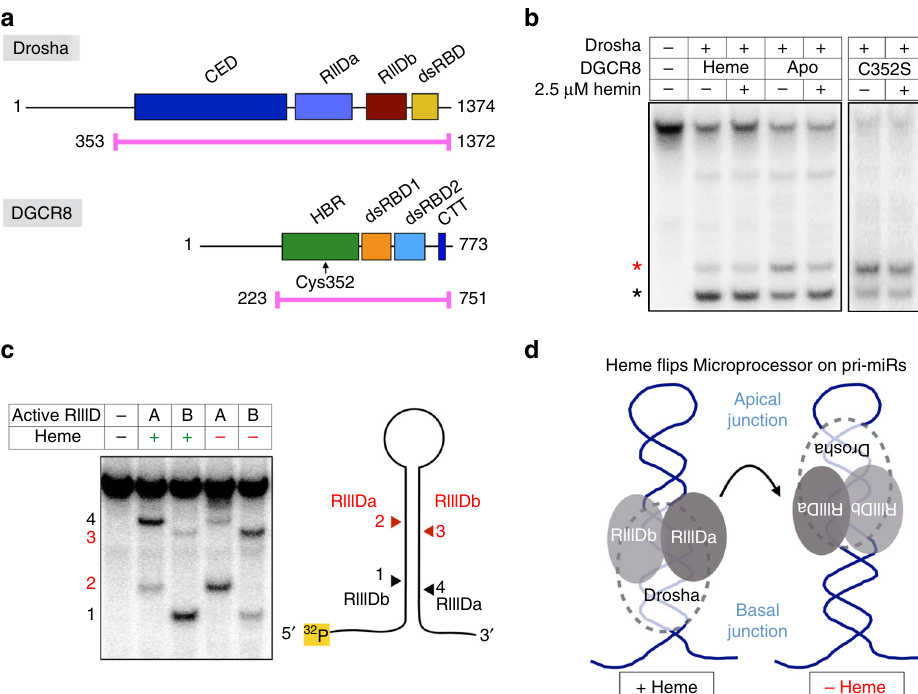
Fig. 1 Heme binding reverses the orientation of Microprocessor on pri-miRs. a Domain organization and construct diagrams for Drosha and DGCR8. Recombinant protein complexes were puri fi ed after coexpressing the highlighted regions (magenta). Coexpression of Drosha with DGCR8 Heme , DGCR8 Apo , and DGCR8 C352S yields MP Heme , MP Apo , and MP C352S , respectively. CED central domain, RIIID ribonuclease III domain, dsRBD double- stranded RNA-binding domain, HBR heme-binding region, CTT C-terminal tail. b In vitro pri-miR processing assay using 5 ′ end-radiolabeled pri-miR-143. Reactions involving MP Heme (130 nM), MP Apo (130 nM) and MP C352S (260 nM) are shown. Correct product is shown with a black asterisk, incorrect product is shown with a red asterisk. c In vitro pri-miR processing assays used to orient the RIIID domains of Drosha on a pri-miR, with diagram shown to the right. Substrate shown is pri-miR-21. d Model depicting the heme-induced reversal of Drosha/DGCR8